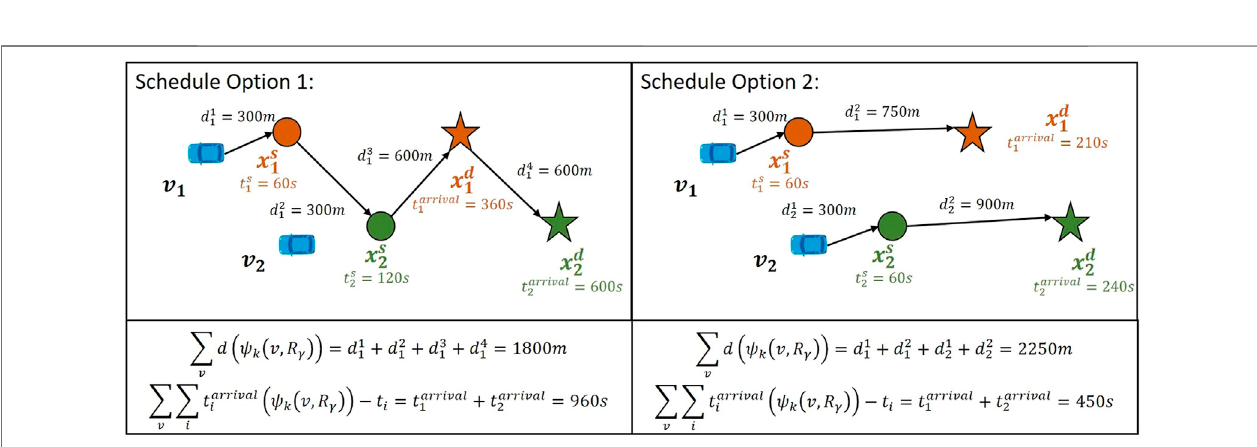
FIGURE3| Sketchshowingthein fl uenceof c dis α and c vot α ontheassignedvehicleschedules.Intheexample,twocustomersrequestatripat t 1 = t 2 =0s.If c dis α ≫ c vot α the pooled schedule option 1 is assigned because ofa smalleroverall driven distance while schedule option two is assigned for c dis α ≪ c vot α because the customers arrive at their destination